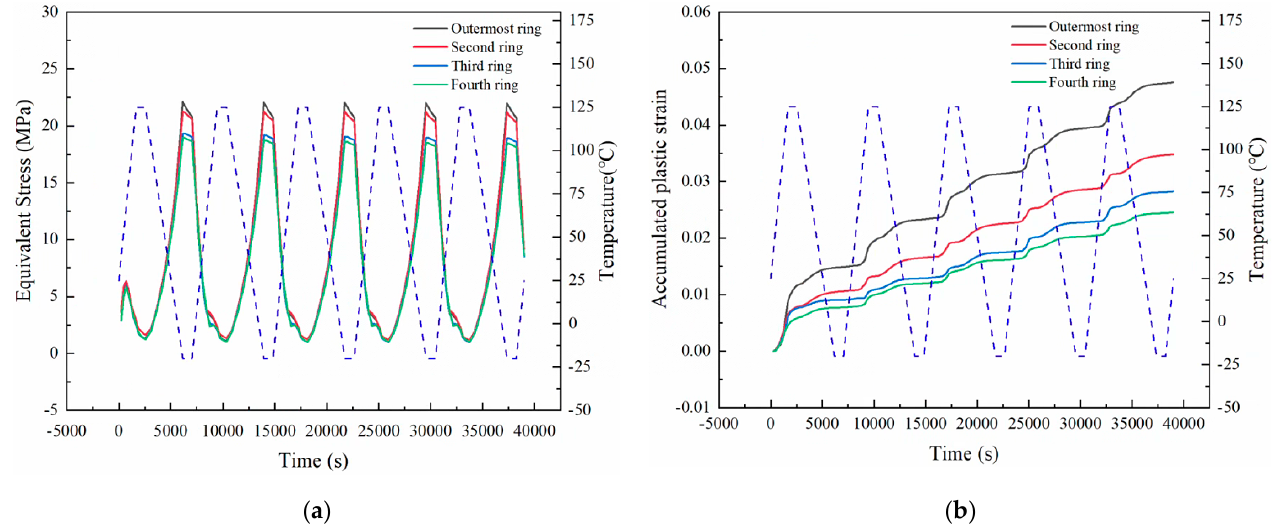
Figure 7. ( a ) Equivalent stress. ( b ) Accumulated equivalent plastic strain of four outer rings’ solder balls.